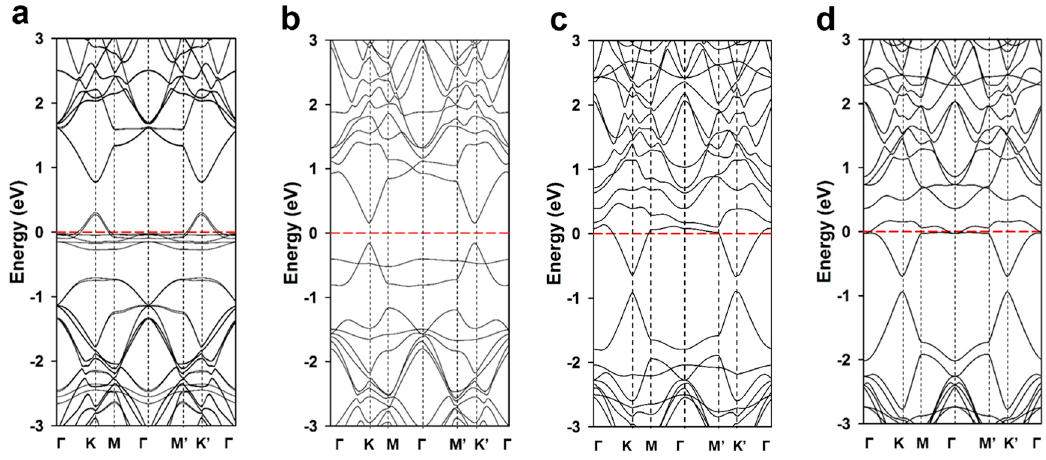
Figure 2. Calculated band structures of the ( a ) 3N-gra, ( b ) 2N1S-gra, ( c ) 1N2S-gra, and ( d ) 3S-gra systems.